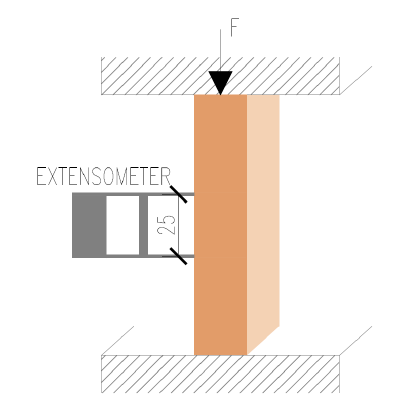
Figure 7. Compresive strenght test with extesometer that records displacements δ on the specimens (range 25 mm).